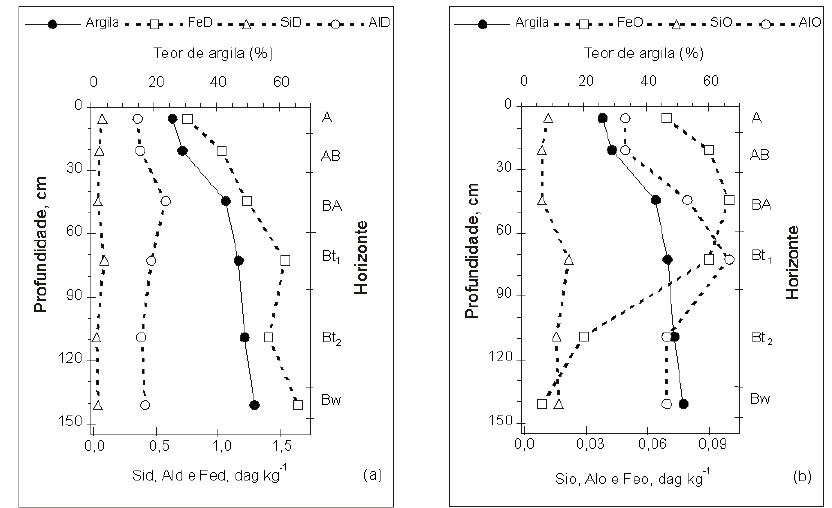
Figura 3. Curva do teor de argila e formas extraídas de Fe, Si e Al com ditionito (a) e oxalato (b) em profundidade no Argissolo Amarelo distrófico latossólico - Bw (Figura 4), livres de coesão e com estrutura fraca em blocos subangulares se desfazendo em moderada muito pequena granular, no Argissolo Amarelo distrófico latossólico (PAd1), e no Espodossolo Cárbico órtico dúrico (EKo), em toda a sua extensão (Figura 6).